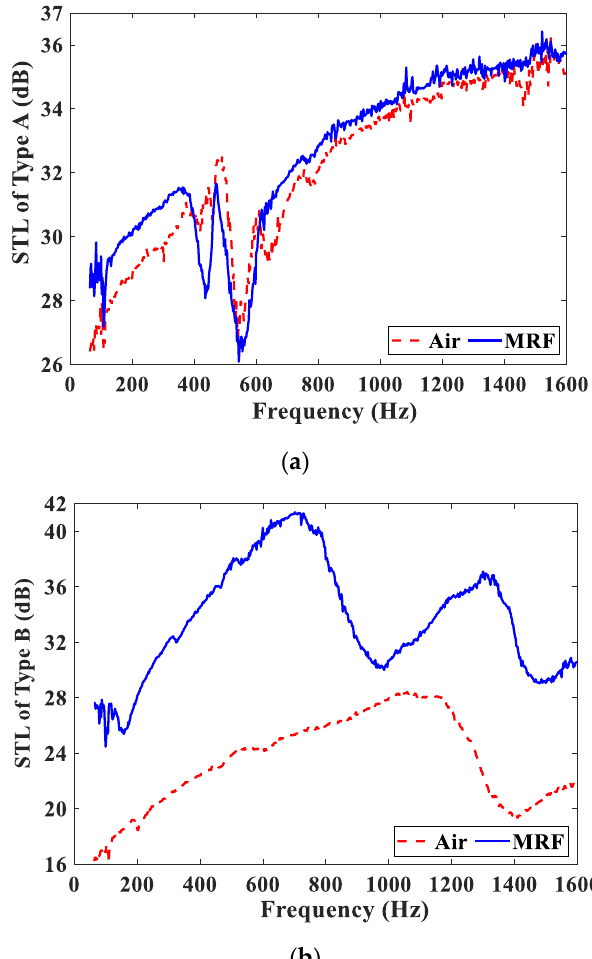
Figure 8. Comparison of STL curves under the same magnetic field intensity. ( a ) Type A − 25; ( b ) Type B − 25.